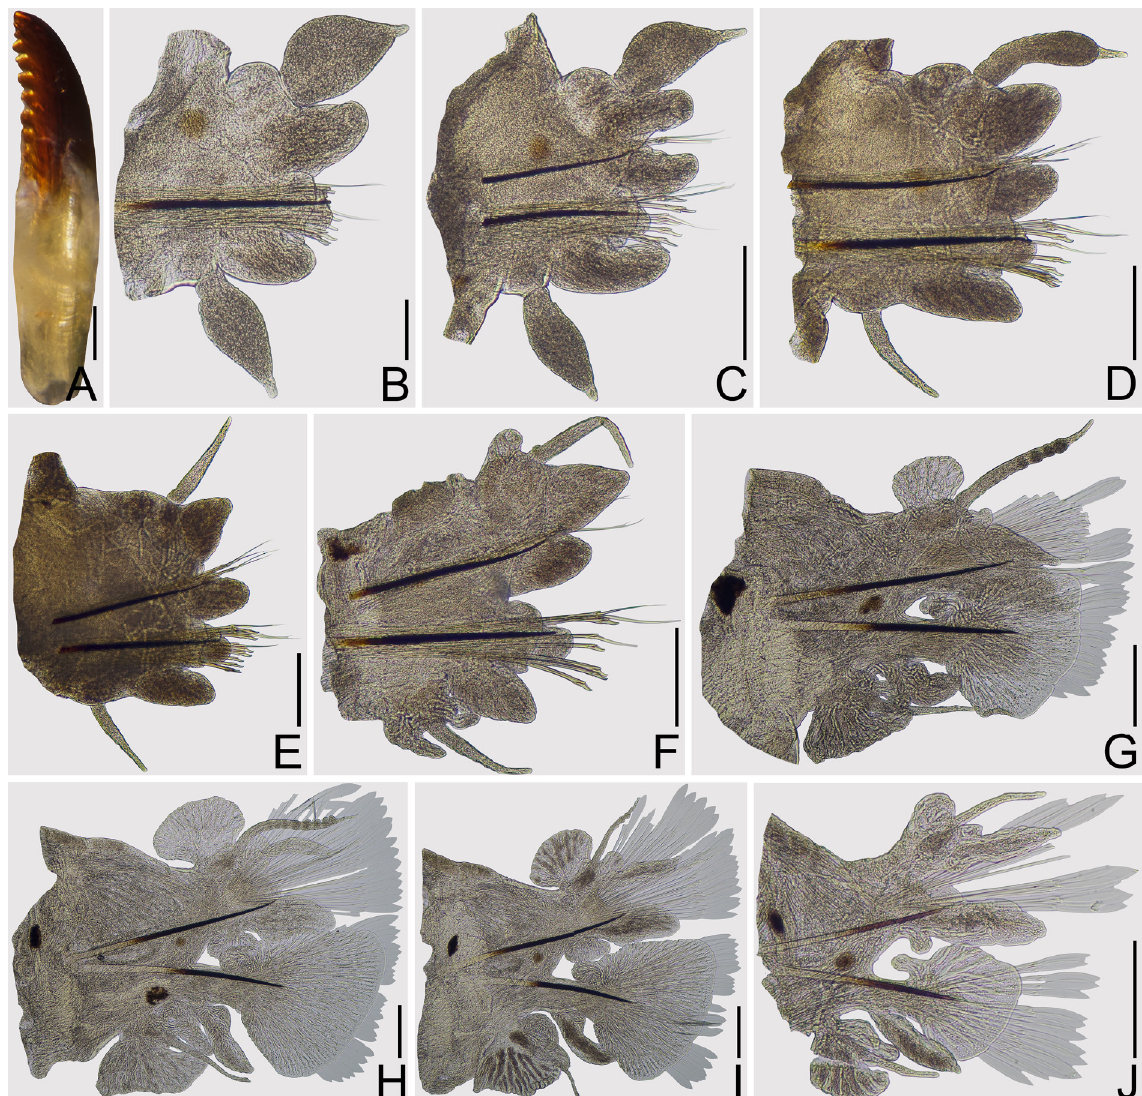
Fig. 6. Perinereis bairdii (Webster, 1884). Topotype male (USNM 1480197). A . Right jaw, dorsal view. B . Chaetiger 2, left parapodium. C . Chaetiger 3, left parapodium. D . Chaetiger 7, left parapodium. E . Chaetiger 10, left parapodium. F . Chaetiger 14, left parapodium. G . Chaetiger 15, left parapodium. H . Chaetiger 30, left parapodium. I . Chaetiger 50, left parapodium. J . Chaetiger 72, left parapodium. Scale bars: A–B, J = 0.1 mm; C–I = 0.2